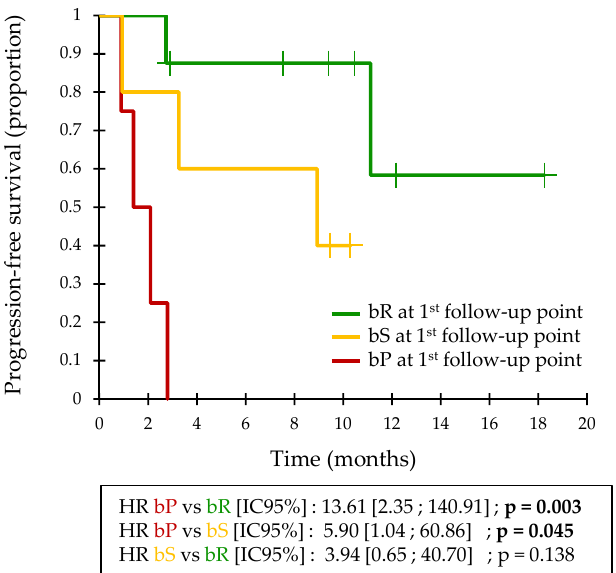
Figure 1. Kaplan–Meier estimate of the PFS in the validation cohort, based on the biological response assessment at the first follow-up point.